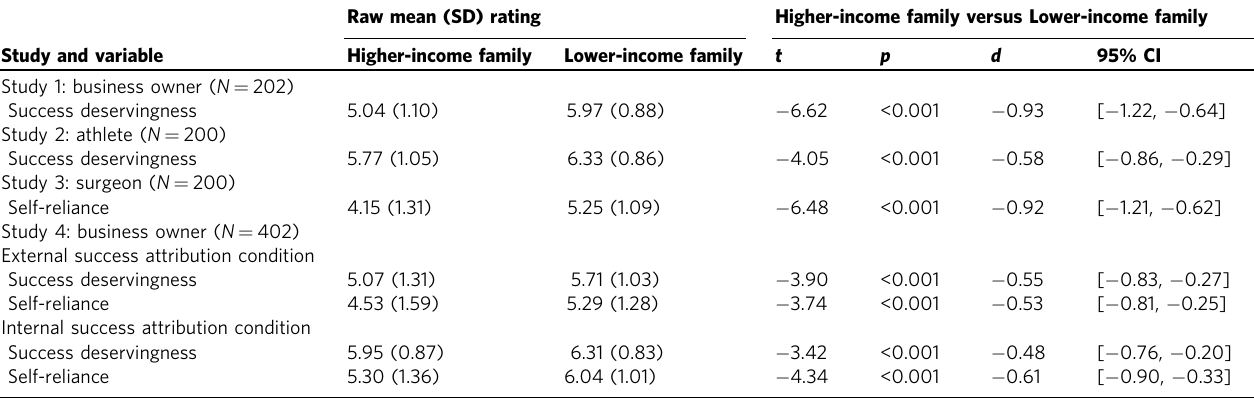
Table 2 Descriptive and inferential statistics across studies 1 –